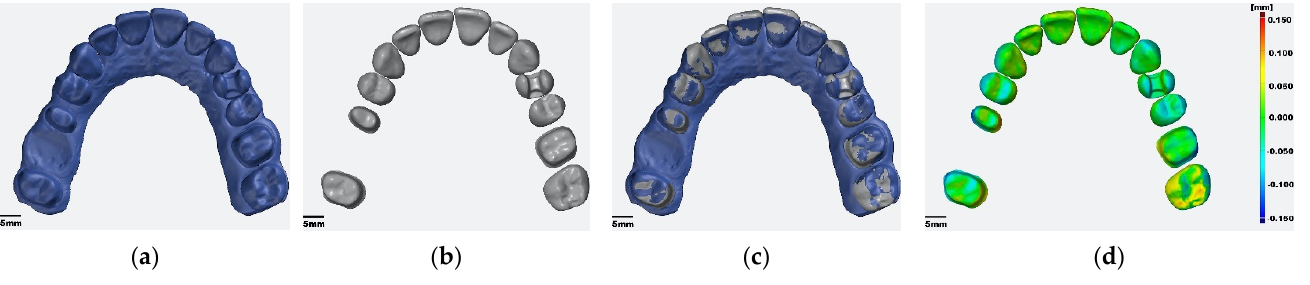
Figure 2. Principle of trimming of all test casts, best-fit alignment, and surface comparison: ( a ) reference cast; ( b ) test cast; ( c ) superimposition of reference and test cast; ( d ) surface comparison [Scale ± 150 µm].